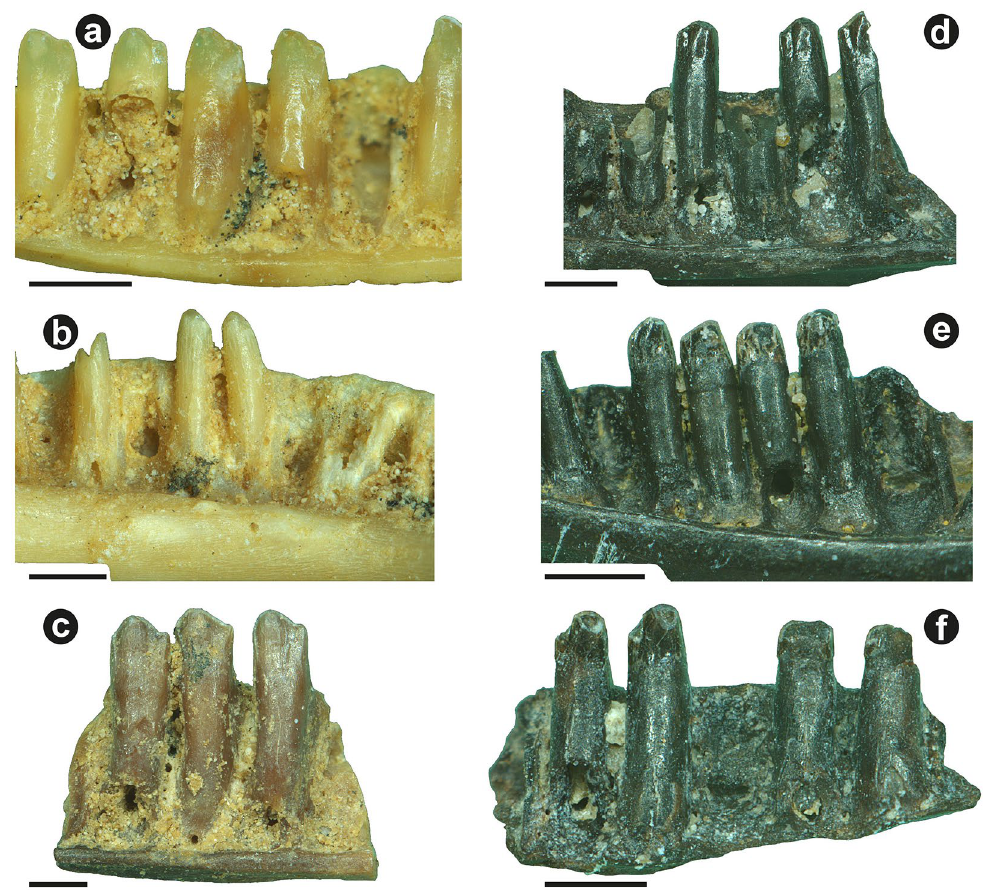
Figure 4. Corrosion in Quaternary lizards from Qesem Cave, Israel, and Hummal, Syria: ( a ) teeth of unidentified lacertid (Liz1-c2) from Concentration 1 62 at Qesem Cave showing light corrosion damage; ( b ) teeth of unidentified gecko (Liz1-a5) from Concentration 1 at Qesem Cave showing no clear corrosion damage but many small, longitudinal fractures; ( c ) teeth of unidentified lacertid (Liz2-f7) from Concentration 2 62 at Qesem Cave showing light damage attributed to abrasion, possibly trampling; ( d ) teeth of unidentified lacertid (Herp1-a8) from Hummal showing no evidence of corrosion; ( e ) teeth of unidentified lacertid (Herp1-a5) from Hummal showing no corrosion to crown (only some abrasion) but a lightly corroded shaft (type 2 corrosion); ( f ) teeth of unidentified lacertid (Herp1-b3) from Hummal showing type 2 corrosion, but where the crown has been effaced on posterior teeth, probably by spalling. Scale bars: 0.5